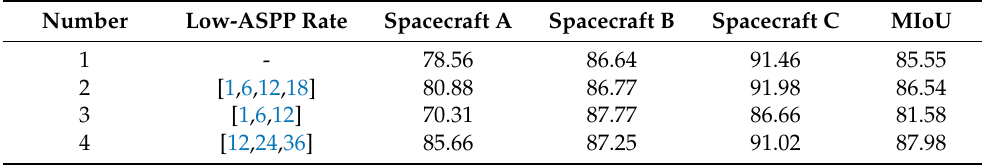
Table 6. The MIoU results of the second ASPP module comparative experiments on the test